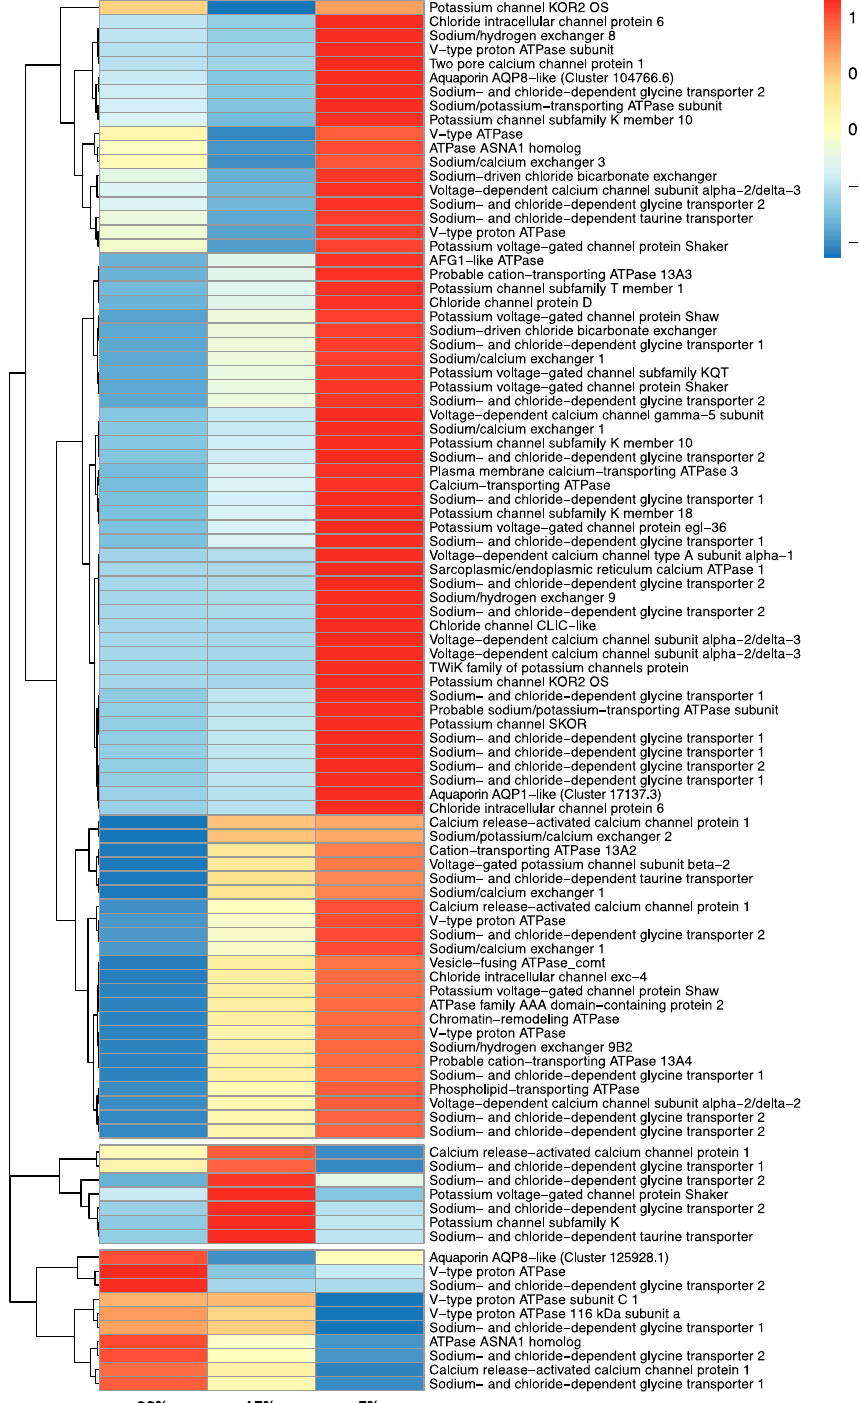
Figure 2. Heatmap showing relative fold change expression of differentially expressed putative osmoregulatory genes in blue mussels ( M. edulis ) from low salinity exposure treatment comparisons, with SwissProt gene transcript descriptions (see Spreadsheet S3 for transcript identification and FPKM values). Colour scale bar indicates relative expression: red = upregulation; blue = downregulation.